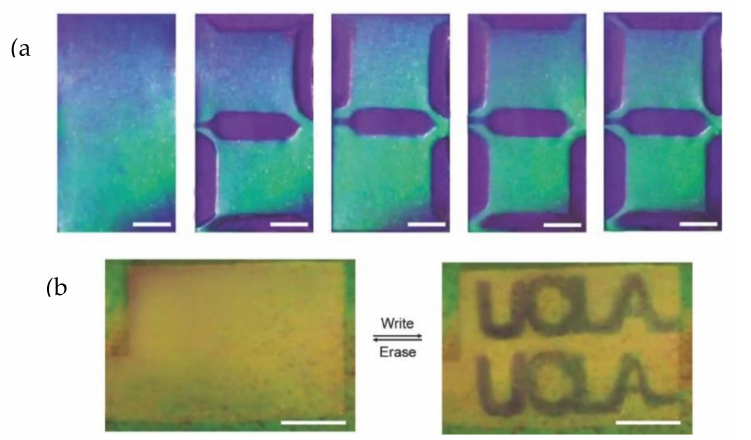
Figure 11. Rewritable photonic papers. ( a ) Selected images of a photonic paper sequentially demon- strating digits 0–9. ( b ) Writing and erasing a “UCLA” pattern with font size of 10 on a photonic paper. The scale bars are all 3 mm in length. (Reproduced with permission from [142]. Copyright Willey and Sons,